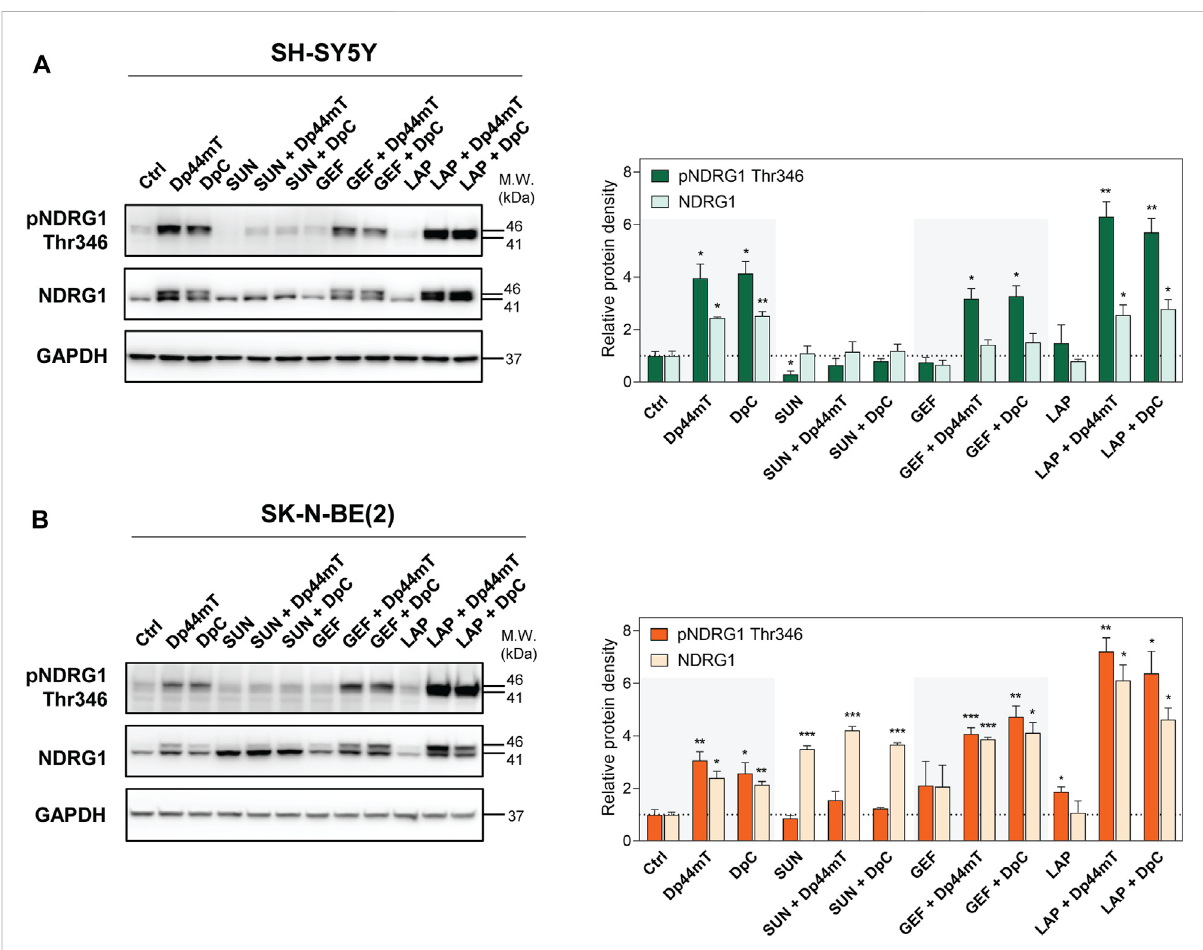
FIGURE 8 Western blotting of NDRG1. The changes in the levels of phosphorylated NDRG1 (Thr346) and total NDRG1 protein were detected in SH-SY5Y (A) and SK-N-BE(2) (B) cells after a72-hour incubation with either a control medium or amedium containing thedrugs, including TKIs (SUN, GEF, or LAP) and thiosemicarbazones (Dp44mT or DpC) alone or in combination. The drugs were used at concentrations of IC 50 for 72 h as listed in Table 2. Representative blots(left)and theirdensitometricquanti fi cation(right)ofthree independentexperiments are shown. The dataare presented as mean ± SD ( n = 3) normalized to GAPDH that was used as the protein-loading control. * p < 0.05, ** p < 0.01, *** p < 0.001 relative to the untreated controlsamples;the p valueswereevaluatedusingWelch ’ sANOVAfollowedbyDunnett ’ sT3multiplecomparisonstest.Thedottedhorizontallinein the graph represents the corresponding protein levels detected in the control